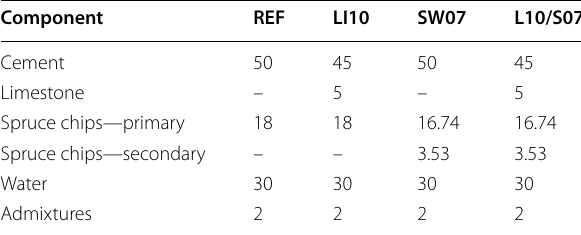
Table 1 Composition (%) of designed mixtures—reference and modified by limestone and secondary spruce chips Component